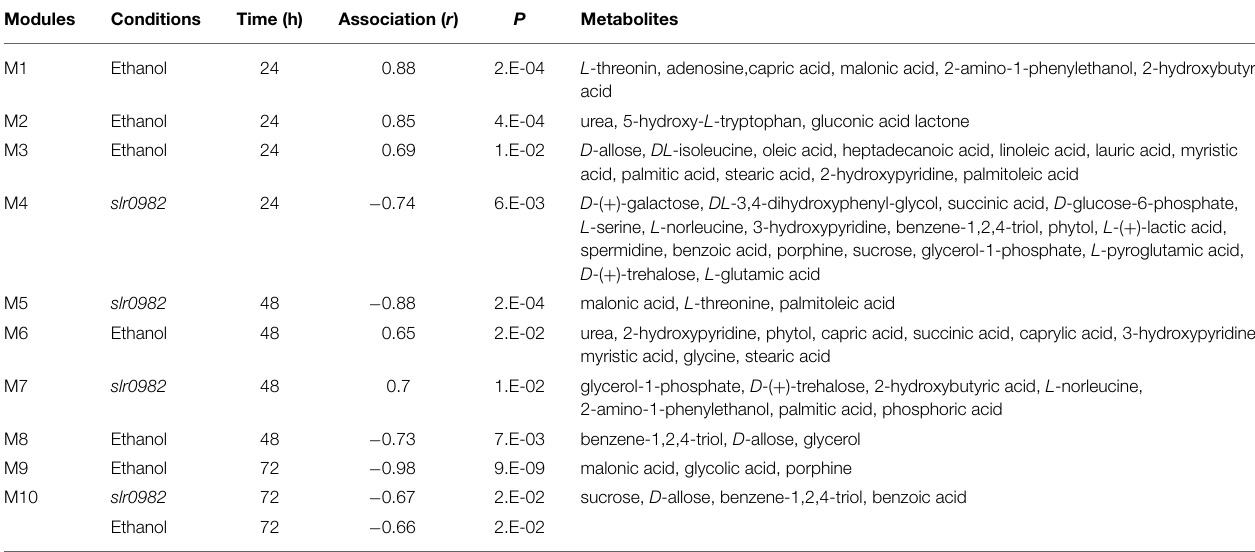
TABLE 2 | Metabolites included in each of the highly associated modules * . Modules